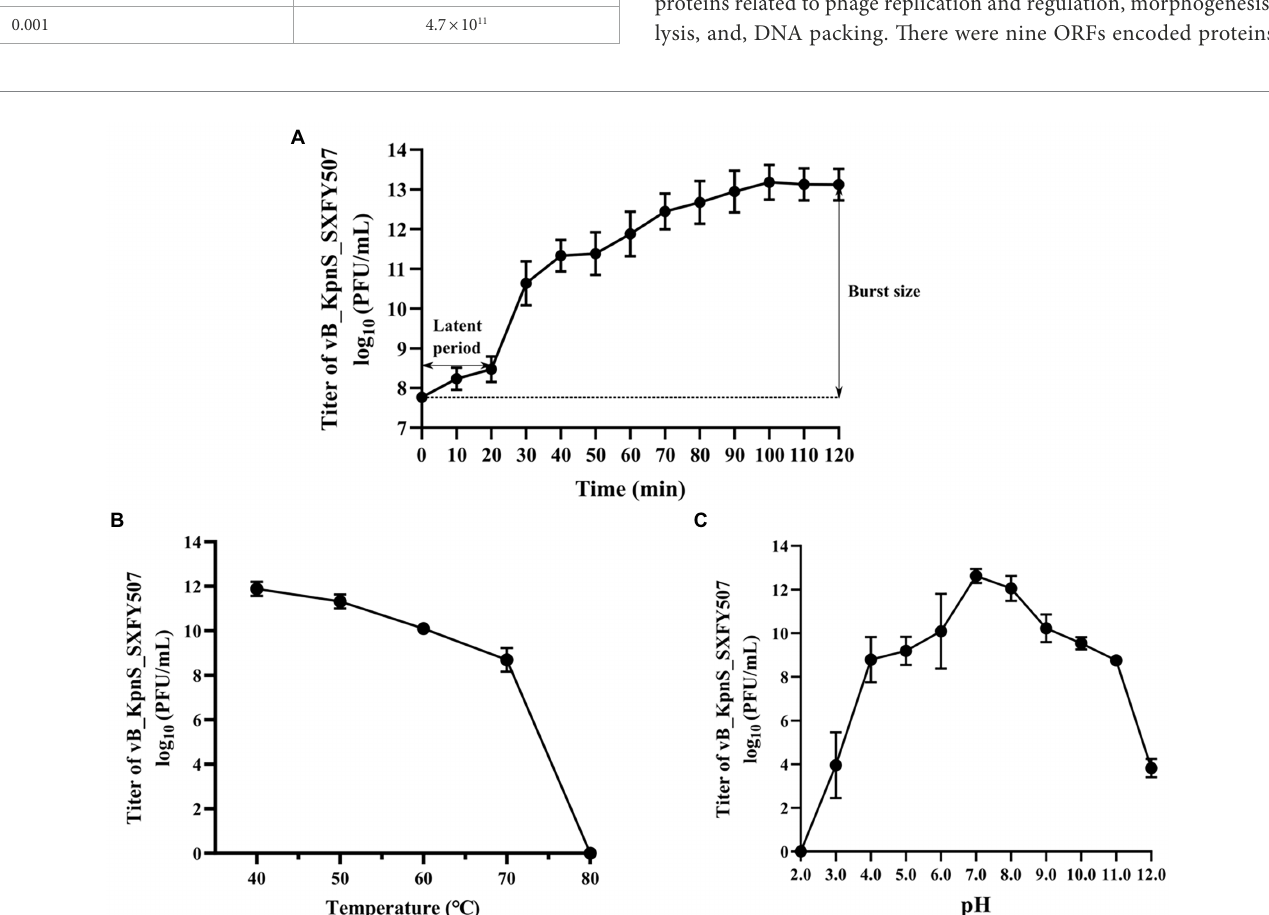
FIGURE 2 Physiological characterization of phage vB_KpnS_SXFY507. (A) One-step growth curve of phage vB_KpnS_SXFY507; (B) Thermal stability of phage vB_ KpnS_SXFY507; and (C) pH stability of phage vB_KpnS_SXFY507. All assays were performed in